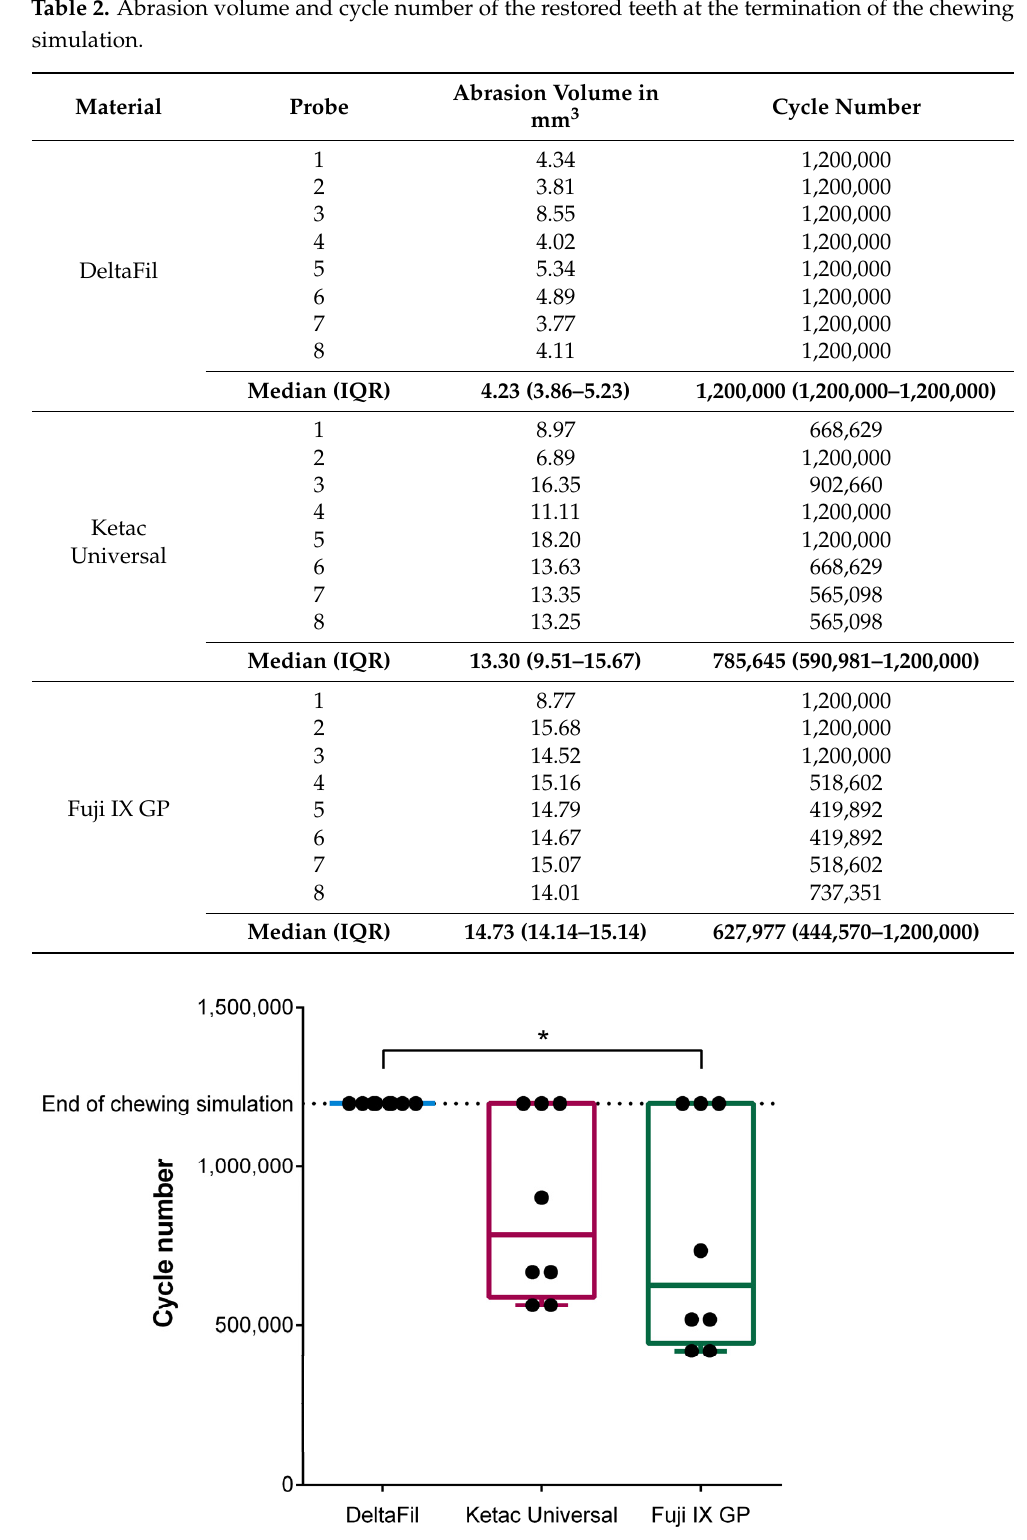
Figure 3. Cycle number of the restored teeth at termination of the chewing simulation. All teeth restored with DeltaFil reached the maximum number of 1,200,000 cycles. Restorations with DeltaFil lasted significantly longer than restorations with Fuji IX GP (‘*’: p ≤ 0.05). The error bars represent the minimum and maximum values of the measured data.